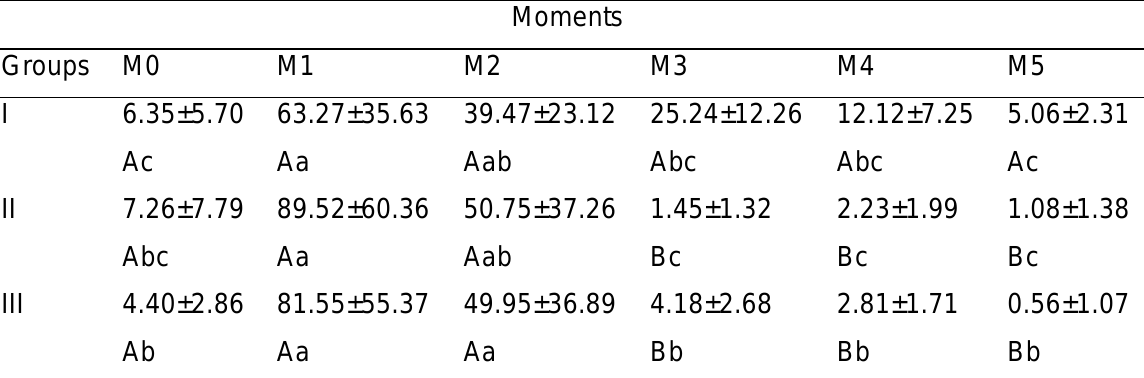
Table 2: Average values of venom (ng/ml), obtained by ELISA, in dogs at control and different moments after crotalic venom inoculation.